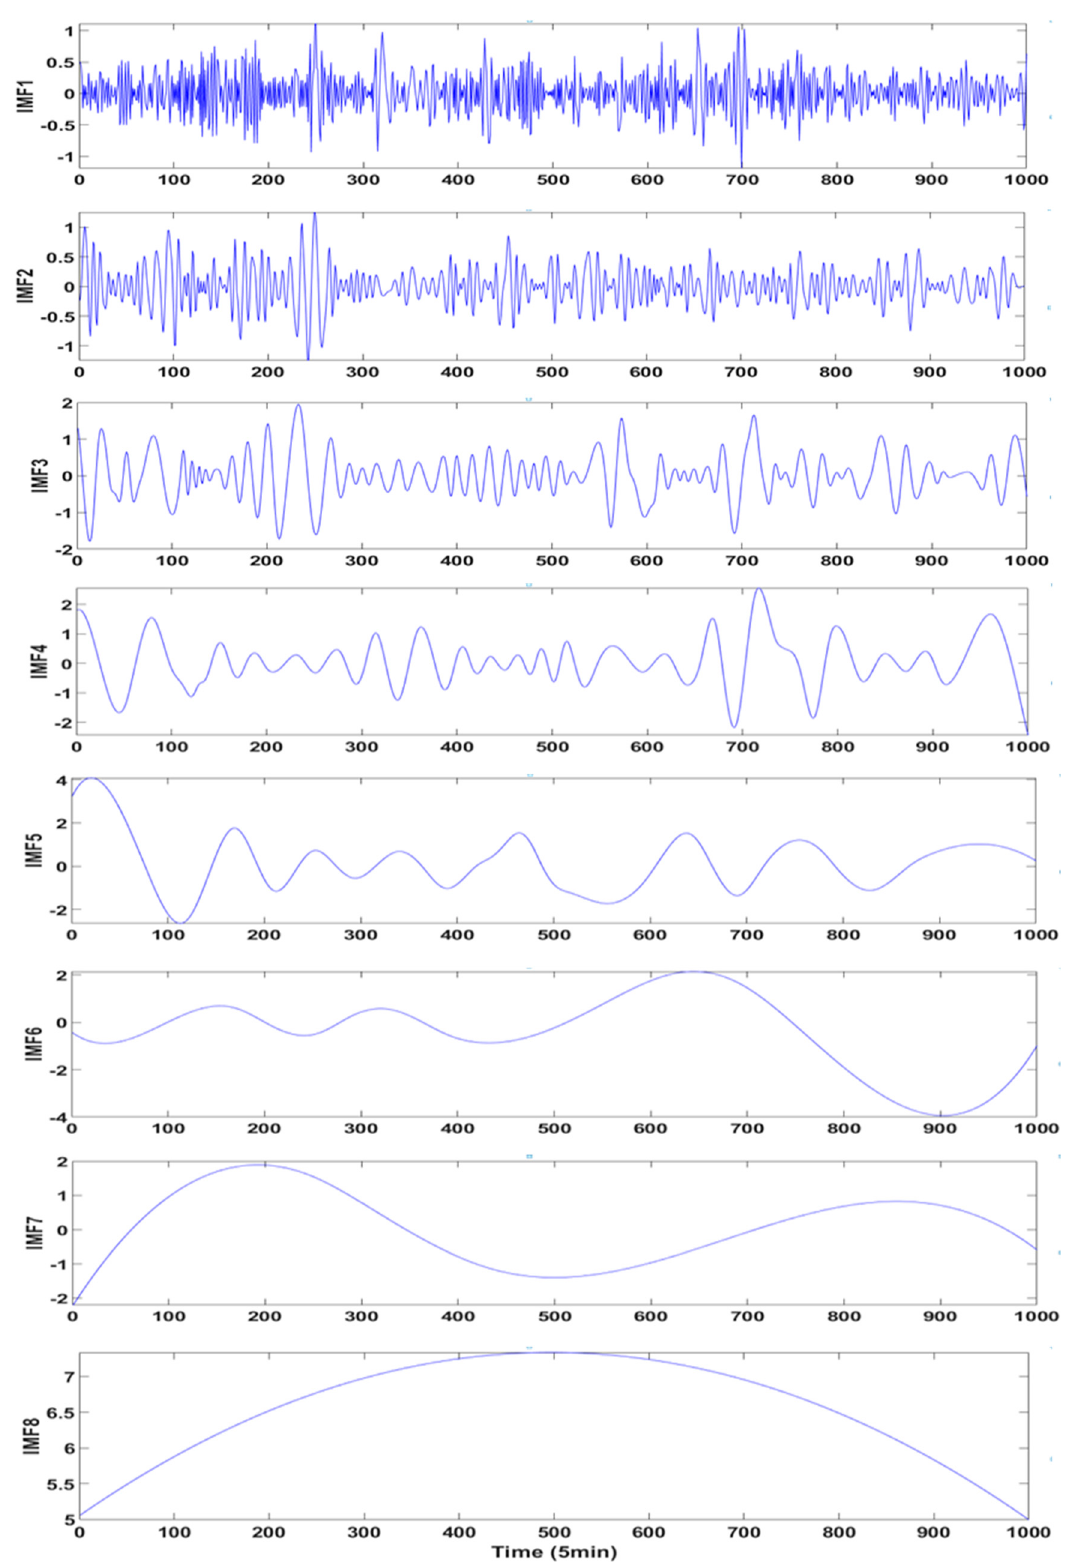
Figure 5. The waveforms of components and residual terms decomposed by empirical mode decomposition (EMD).